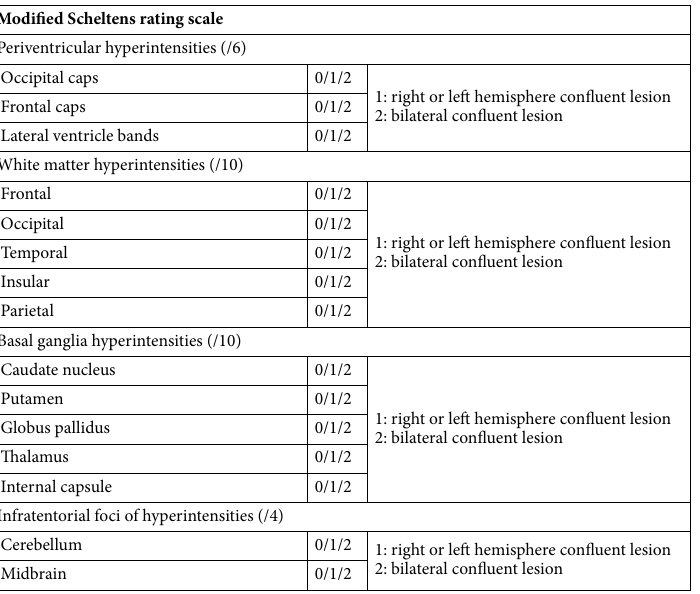
Table 1. Rating of FLAIR hyperintensities according to a modified Scheltens rating